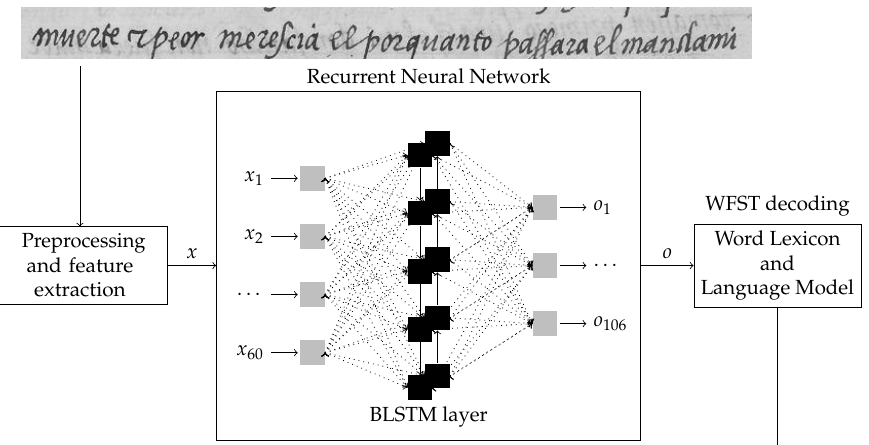
Figure 5. Bi-directional Long-Short Term Memory (BLSTM) system architecture. The BLSTM RNN outputs posterior distributions o at each time step. The decoding is performed with Weighted Finite State Transducers (WFST) using a lexicon and a language model at word